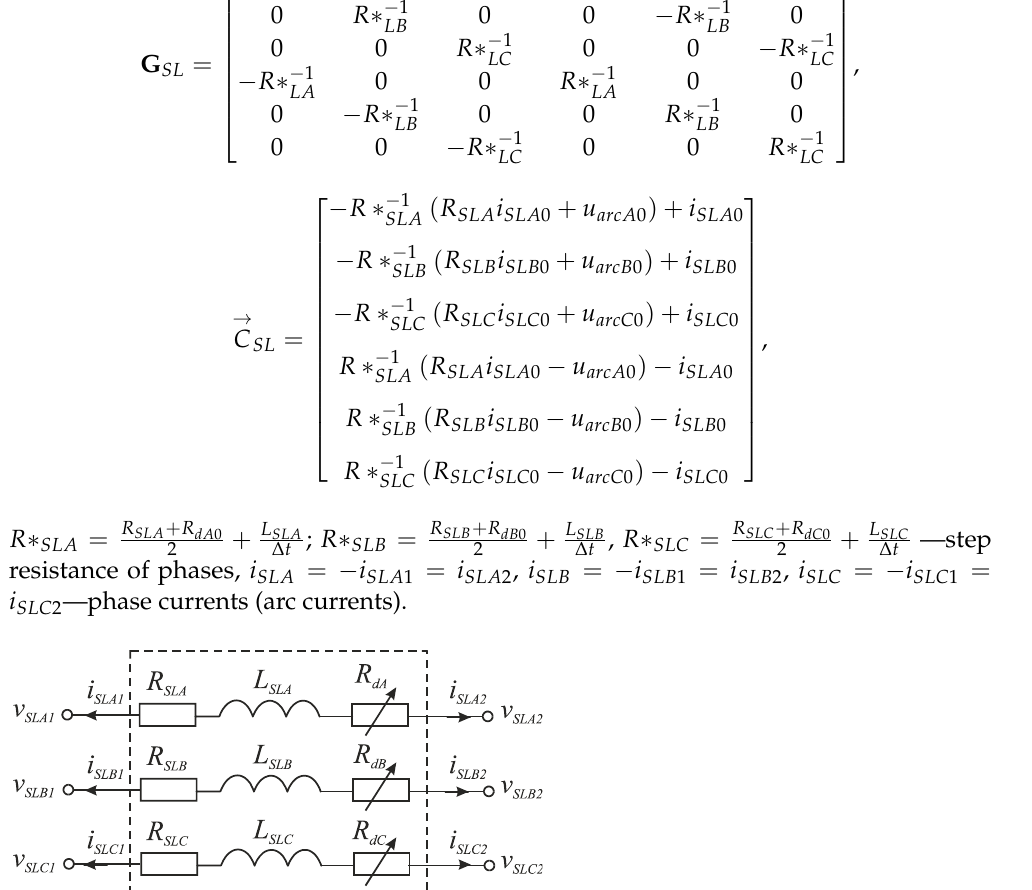
integration step; pole potential vectors and coefficient matrices: